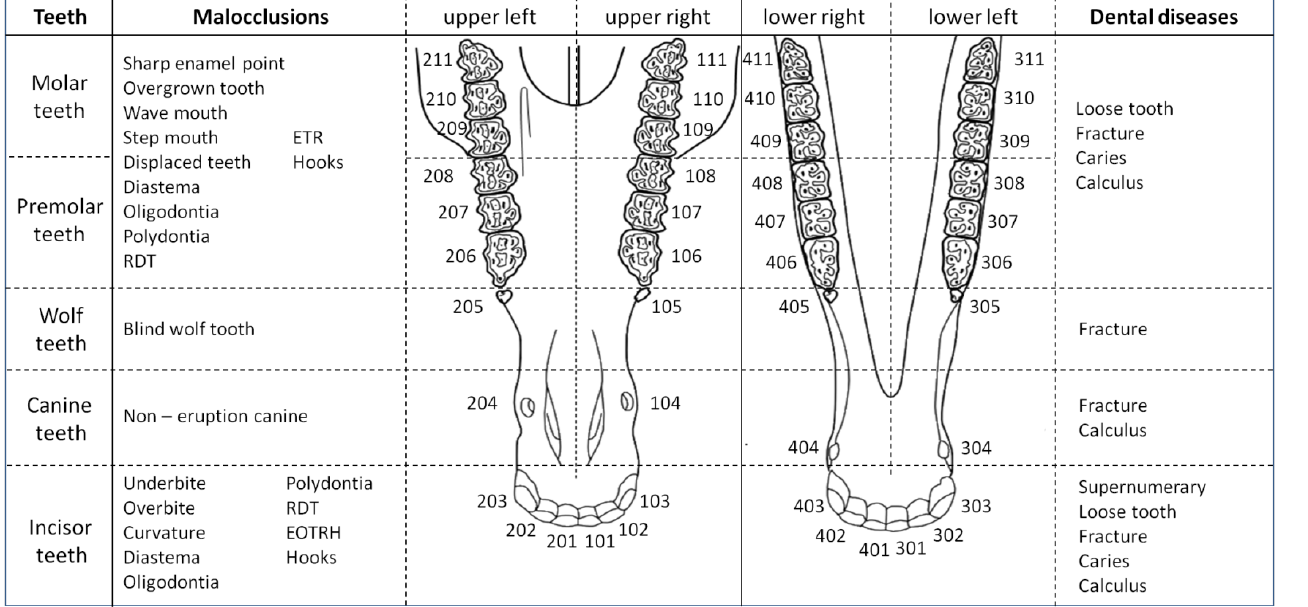
Figure 2. Classification of the malocclusions and dental diseases of the incisor (101, 102, 103, 201, 202, 203, 301, 302, 303, 401, 402, and 403); canine (104, 204, 304, and 404); wolf (105, 205, 305, and 405); premolar (106, 107, 108, 206, 207, 208, 306, 307, 308, 406, 407, and 408); and molar (109, 110, 111, 209, 210, 211, 309, 310, 311, 409, 410, and 411) teeth in horses. ETR—excessive transverse ridges; RDT — retained deciduous teeth; EOTRH — Equine Odontoclastic Tooth Resorption and Hyperce- mentosis syndrome.